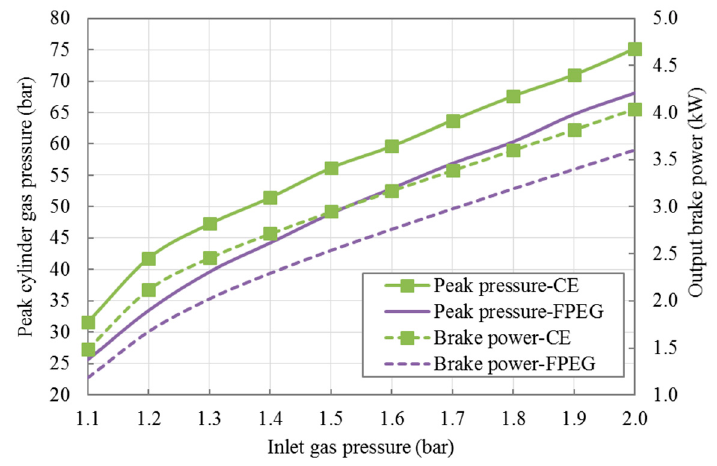
Figure 11. Engine-indicated power and peak pressure with different intake pressures.